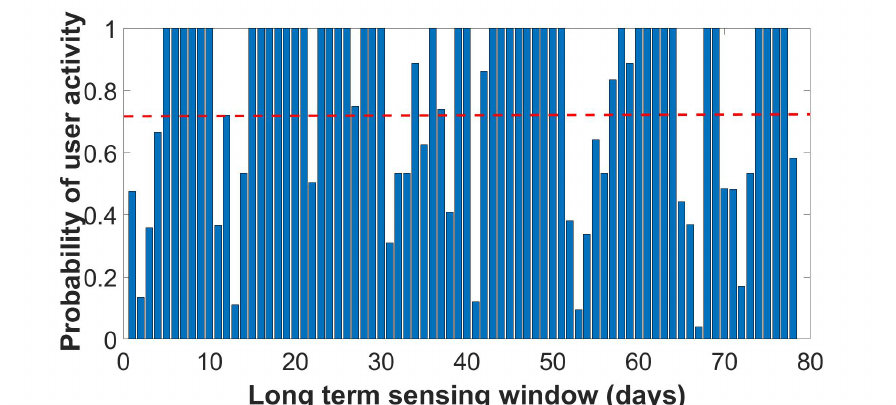
Figure 5. Probability of the selected high active user during sensing time window.